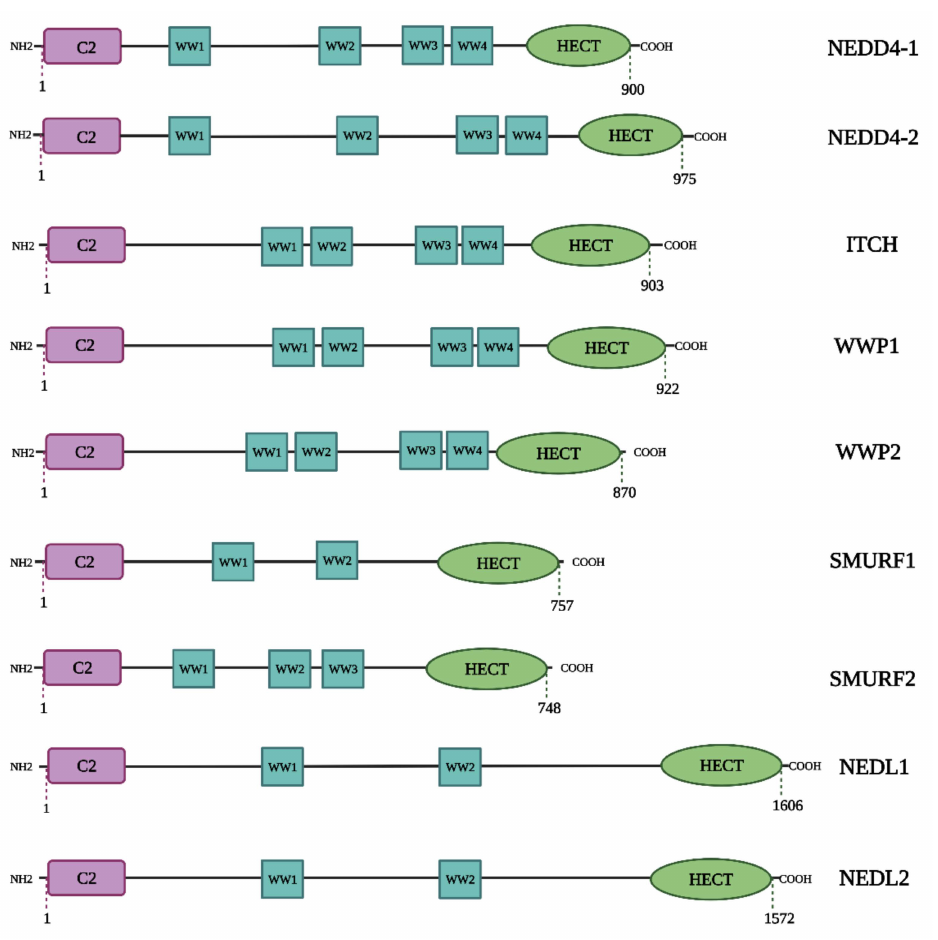
Figure 4. Structures of the 9 NEDD4 subfamily proteins. NEDD4 subfamily ligases contain a C2 domain, 2–4 WW domains that recognize PY motifs, and a HECT domain. Created using